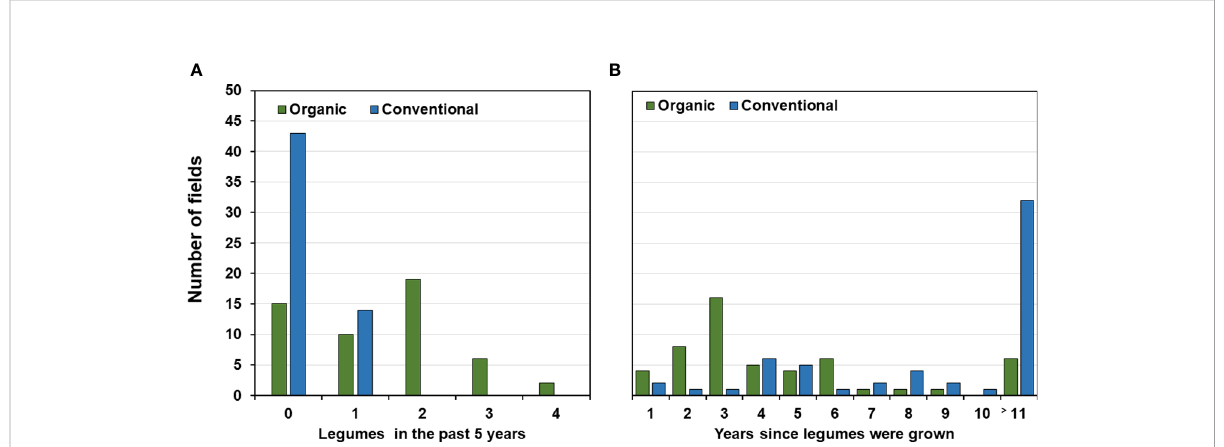
FIGURE 4 Ratio of legumes in organic and conventional crop rotations. (A) Number of fi elds and years since legumes were grown before the faba bean sampling. No information available for 11 or more years. (B) Number of fi elds depending on the frequency of legumes planted for the fi ve-year period preceding the faba bean